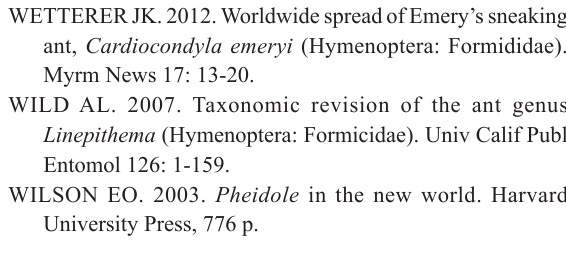
Table SI - Relative abundance of ant species per sample site at the Permanent Preservation Area of the Foz do Chapecó Hydroelectric Power Plant lake in the Guatambu (GUA) and Caxambu do Sul (CXS) municipalities in Santa Catarina, and the Rio dos Índios (RI1 and RI2) municipality in Rio Grande do